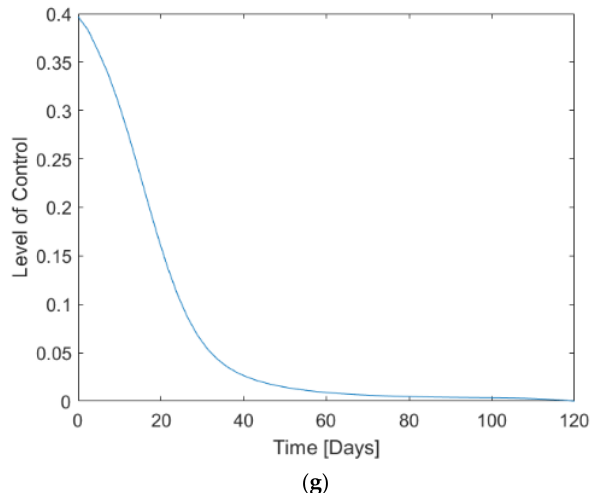
Figure 3. Comparisons between the cases without control and with control under the action of Policy 2: ( a ) Exposed individuals (rural) Eh; ( b ) Exposed individuals (rural) E h ; ( c ) Exposed individuals (urban) E l ; ( d ) Infected individuals (rural) I h ; ( e ) Infected individuals (urban) I l ; ( f ) Control effort u 1 ( t ) ; ( g ) Control effort u 2 ( t ) .